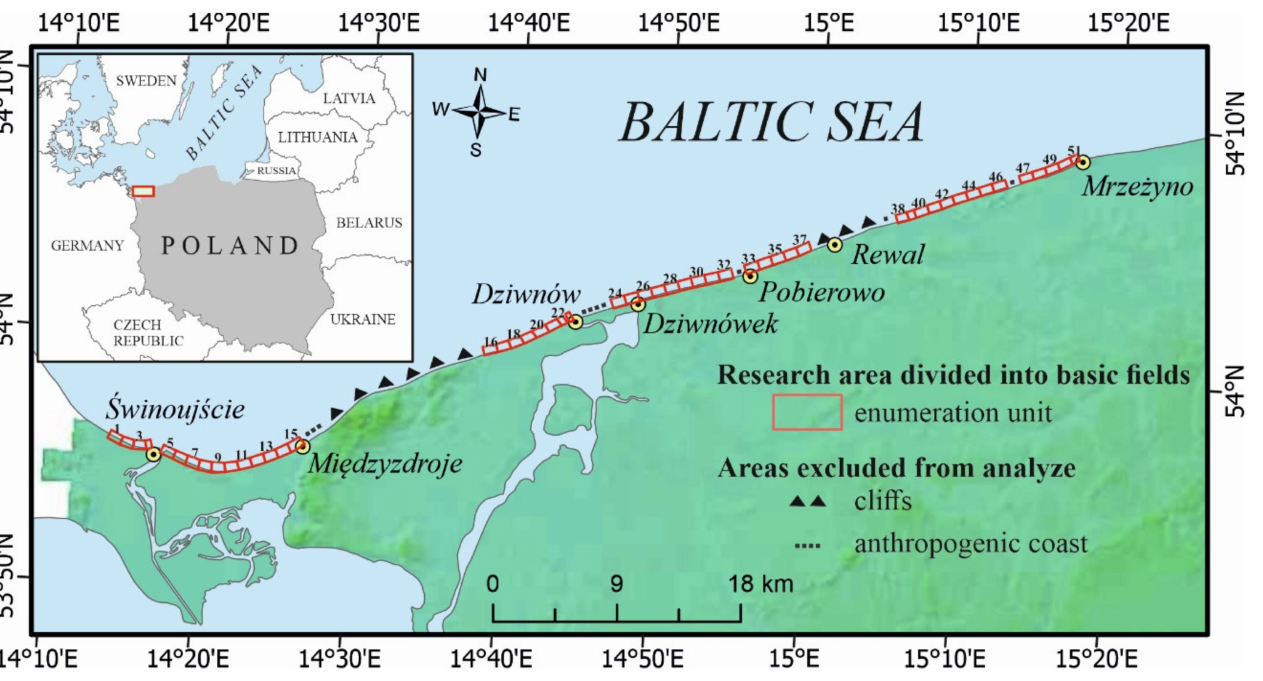
Figure 1. Location of the investigated